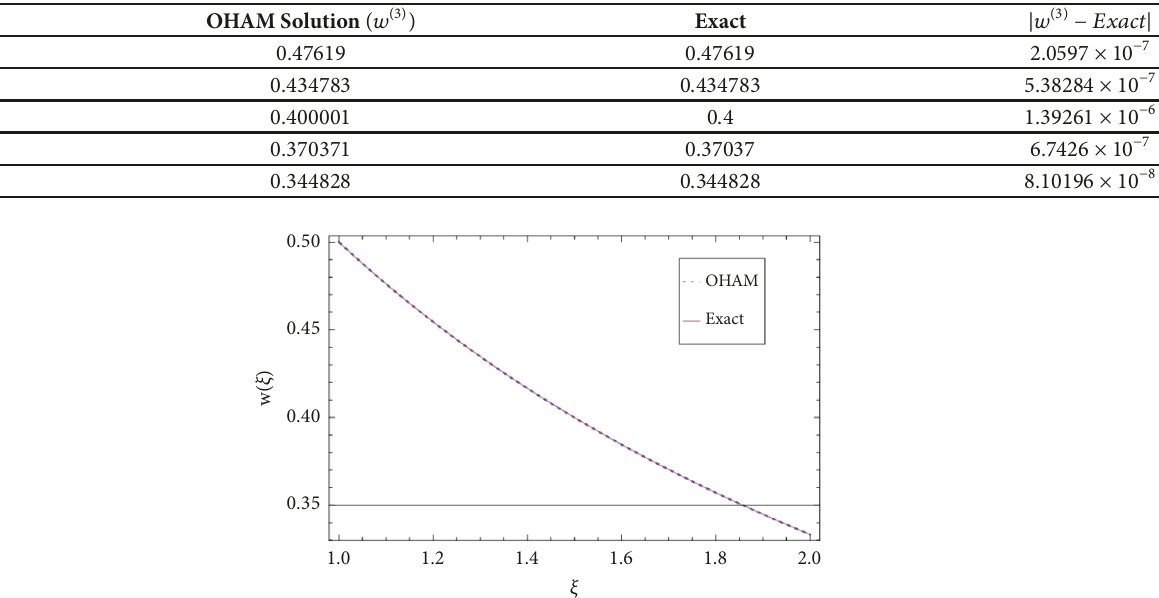
Figure 2: Comparison between exact solution (dashed line) and approximate solution (dotted line) for example 2.